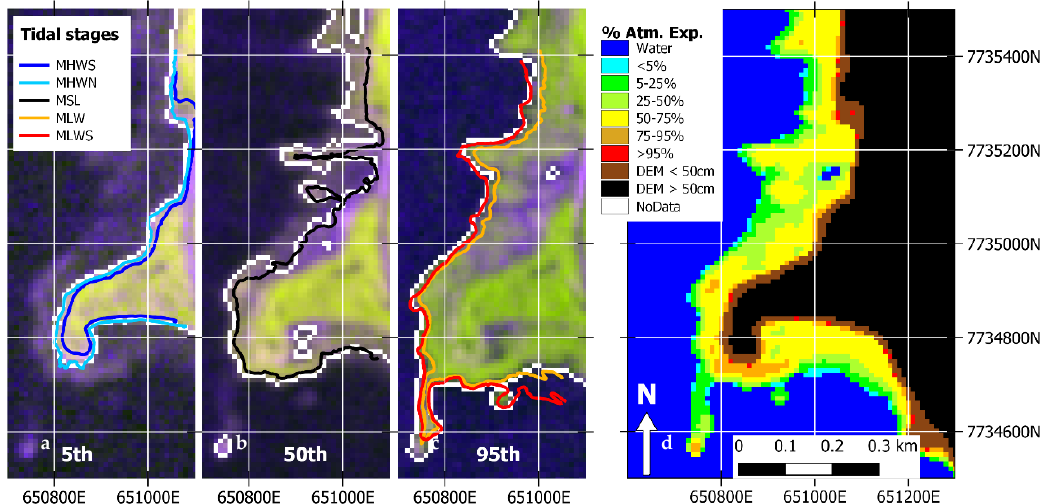
Figure 8. ( a – c ) Backscatter threshold contour lines (white) limiting the land mask in the fifth, 50th, and 95th percentile